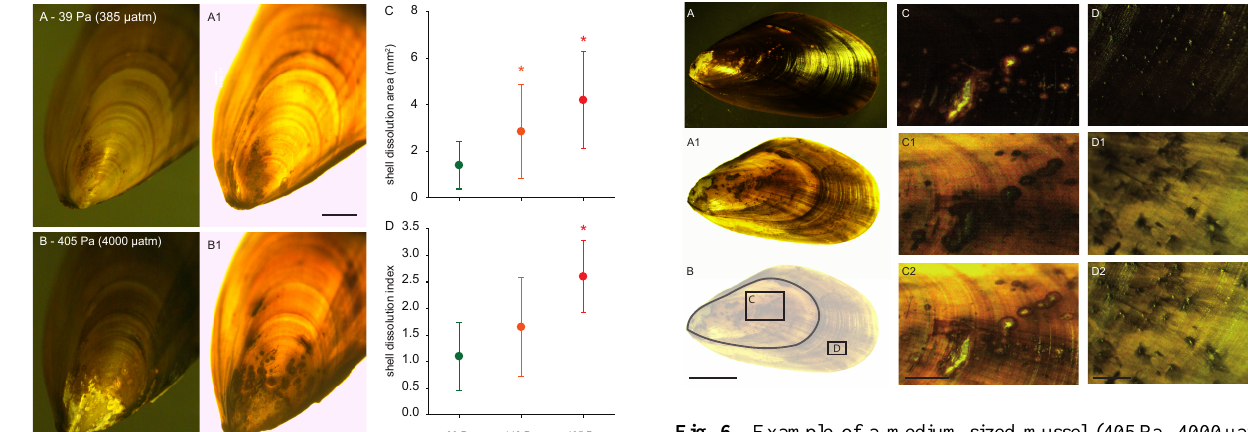
Figure 6 Fig. 6. Example of a medium sized mussel (405Pa, 4000µatm) with dissolution spots on old and newly formed parts of the shell. (A, A1) overview, reflected light (A), transmission light (A1). (B) position of close-up areas 1 (C) and 2 (D). Close up area 1 (C, C1, C2) is located on pre-experimental shell parts (black trace in C indi- cates the size of the mussel at the start of the experiment), close-up area 2 (D, D1, D2) on newly formed shell material. C, D are re- flected light pictures, C1 and D1 are transmission images, C2 and D2 combined reflected and transmission images. White spots are corroded calcite / aragonite material that is visible when the perios- tracum is fractured. These spots appear dark when viewed under transmission light. Scale bars: A to C: 5mm, D to F: 1mm, G to I: